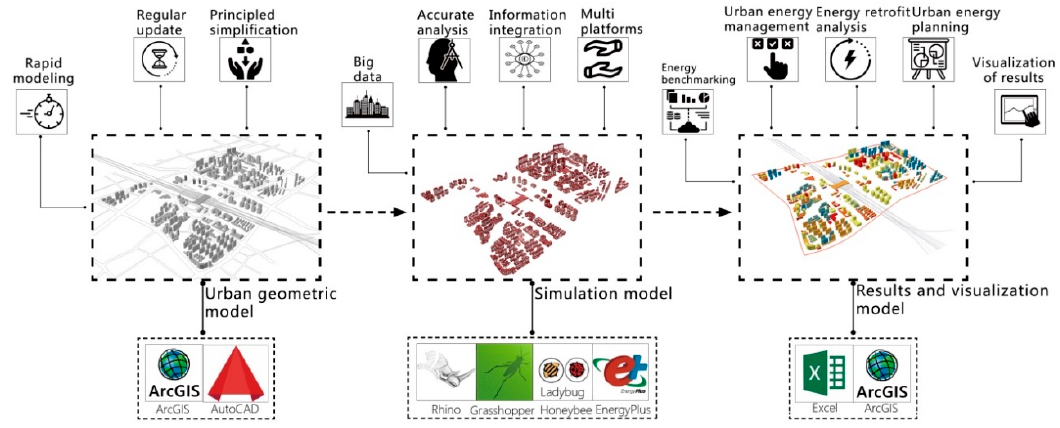
Figure 5. Physical model method workflow.